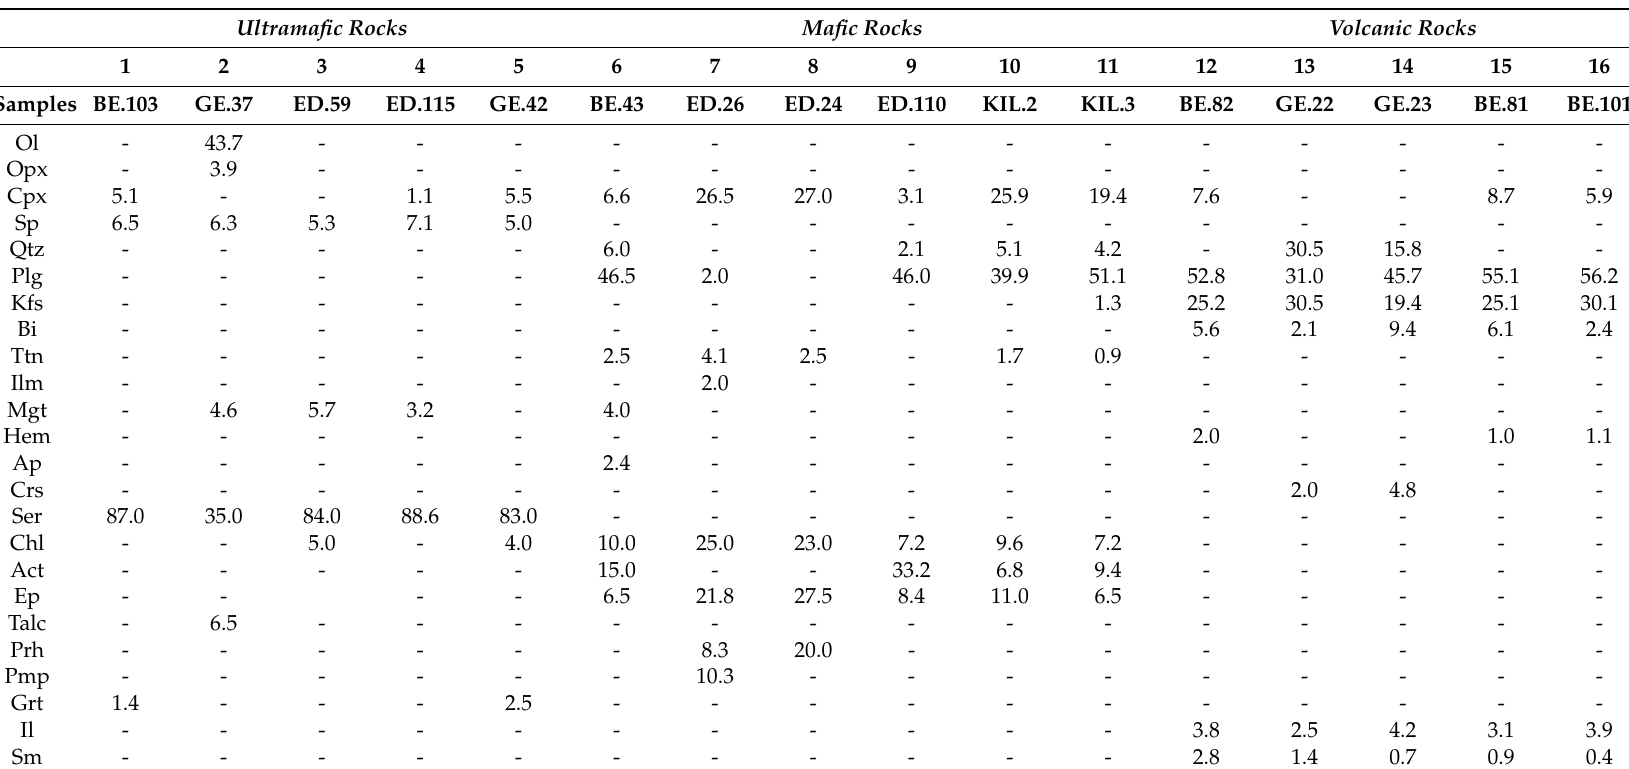
Table 1. Mineralogical composition of the studied rock samples (-: not detected). The quantification errors of 2–3 wt % calculated for each phase according to Bish and Post [43,44].